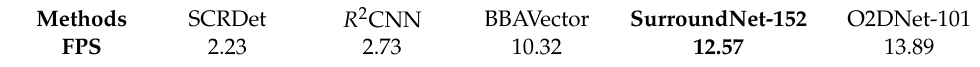
Table 7. Inference speed comparisons with other methods.